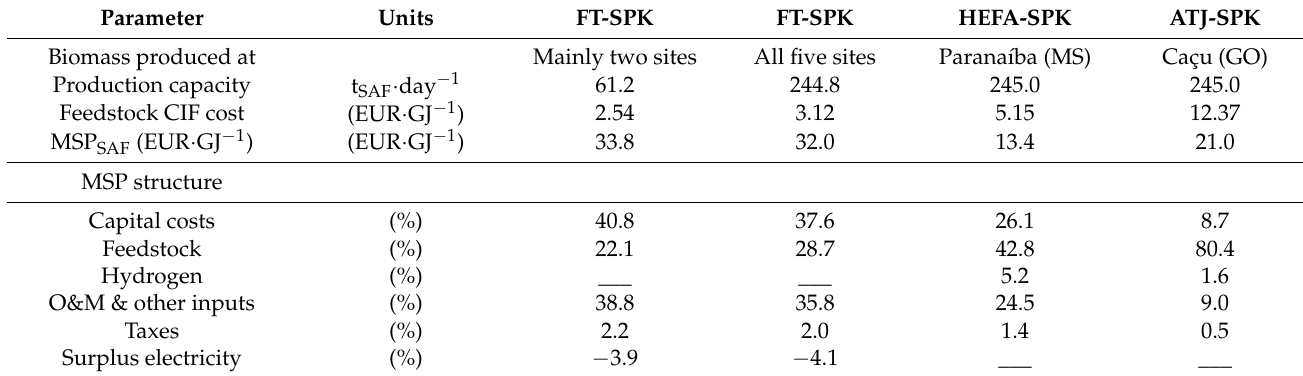
Table 4. Parameters and results of the selected case studies: SAF MSP and its structure (%) for the reference production capacity for the three routes considered.